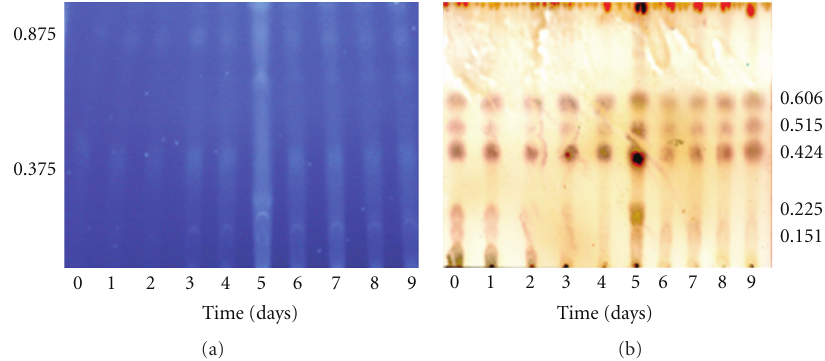
Figure 4: TLC analysis of phenolic compounds of L. campestris germinated seed eluted with a mixture of ethyl acetate-formic acid-ethanol (65:15: 20, v/v/v) and revealed (a) UV light at 360 nm and (b) 10% sulphuric acid.